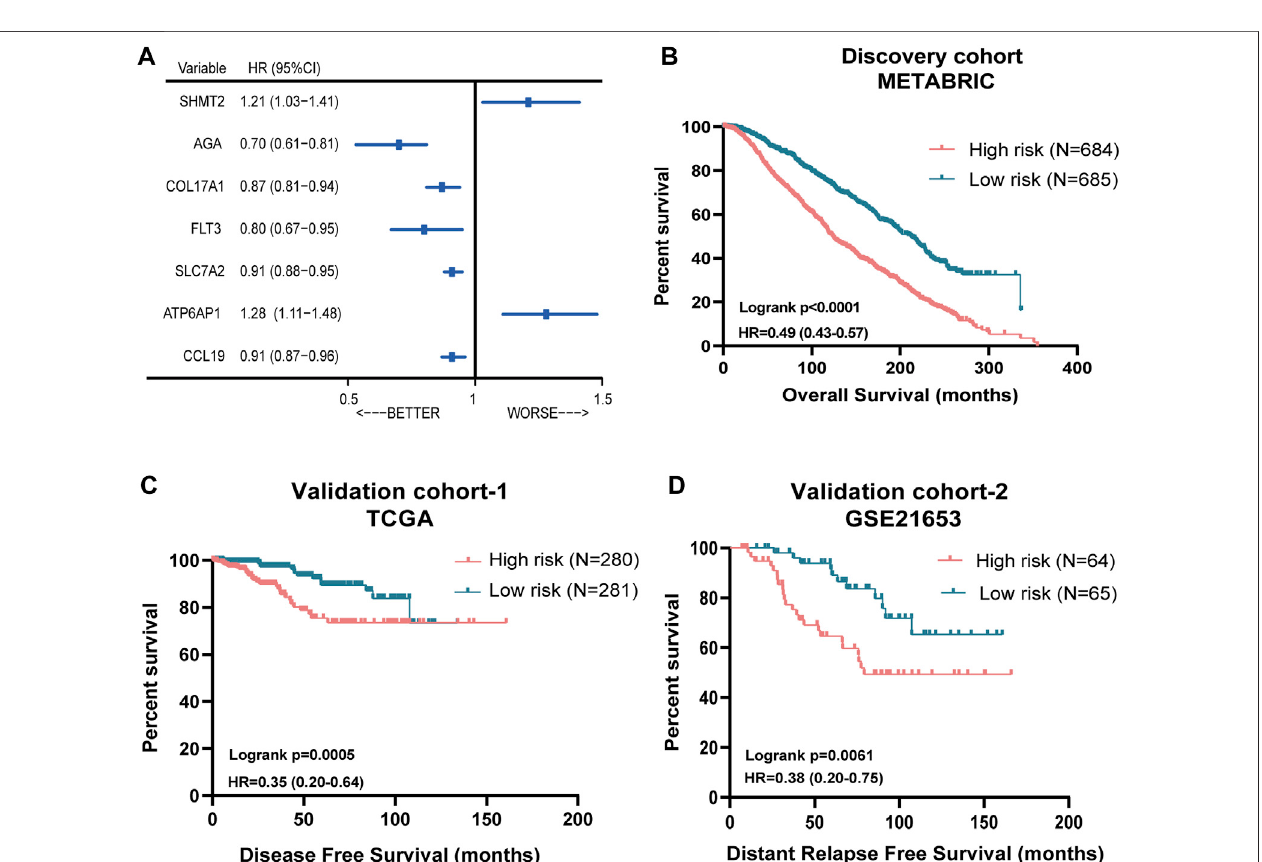
FIGURE 2 | Prognostic signi fi cance of the seven-immune-related-gene IRS in ER (+) and/or PR (+) and HER2 ( − ) breast cancer. (A) Forest plot of prognostic signi fi cance of the seven immune-related genes. (B) Association of IRS with OS in the METABRIC cohort. (C) Association of RS with DFS in TCGA cohort. (D) Association of RS with OS in the GSE21653 cohort. IRS: immune risk signature; METABRIC: Molecular Taxonomy of Breast Cancer International Consortium; TCGA: The Cancer Genome Atlas.